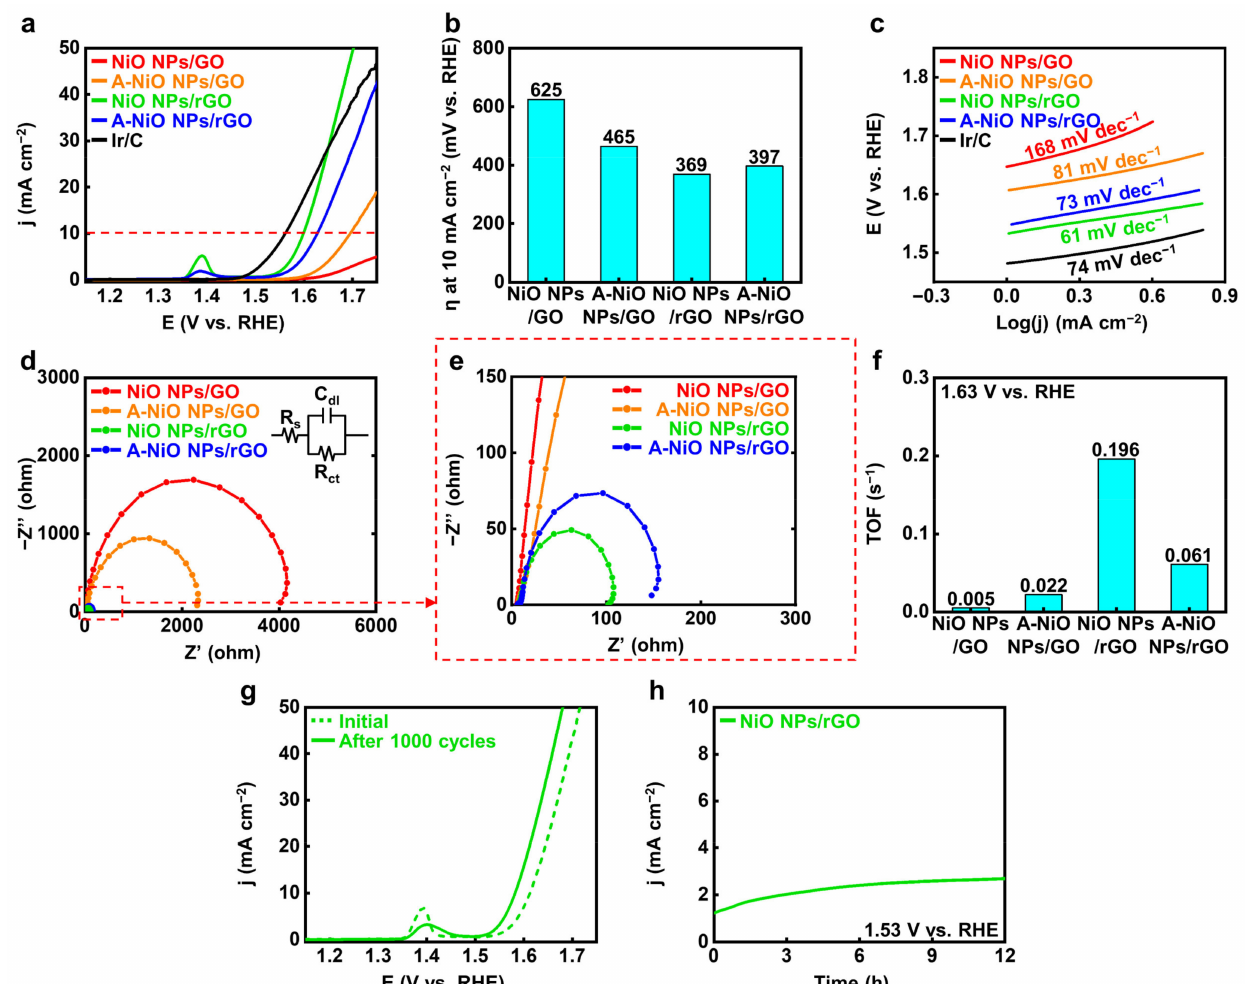
Figure 5. Electrochemical measurements for OER. ( a ) LSV curves for OER and ( b ) corresponding overpotentials at 10 mA cm − 2 of NiO NPs/GO, A-NiO NPs/GO, NiO NPs/rGO, A-NiO NPs/rGO, and Ir/C in 1 M KOH at a scan rate of 5 mV s − 1 . ( c ) Tafel slopes of NiO NPs/GO, A-NiO NPs/GO, NiO NPs/rGO, A-NiO NPs/rGO, and Ir/C. ( d ) EIS curves and ( e ) enlarged data of NiO NPs/GO, A-NiO NPs/GO, NiO NPs/rGO, and A-NiO NPs/rGO at an overpotential of 1.53 V vs RHE. Inset of ( d ) is the Randles circuit of the OER. ( f ) Histograms for TOF of NiO NPs/GO, A-NiO NPs/GO, NiO NPs/rGO, and A-NiO NPs/rGO at 1.63 V vs. RHE. ( g ) LSV curves of A-NiO NPs/rGO before and after 1000 cycles for durability test. ( h ) CA test of A-NiO NPs/rGO under an overpotential of 1.53 V vs. RHE for 12